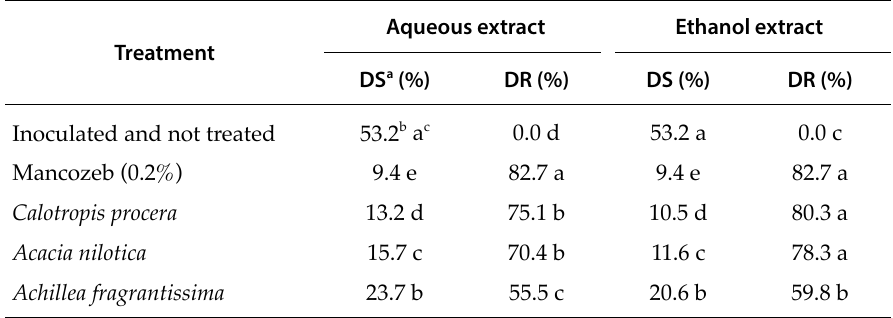
Table 4. Mean early blight severity and proportional (%) disease reduction for tomato plants treated with fungicide, or aqueous or ethanol extracts from three medicinal plants, in a filed trial.